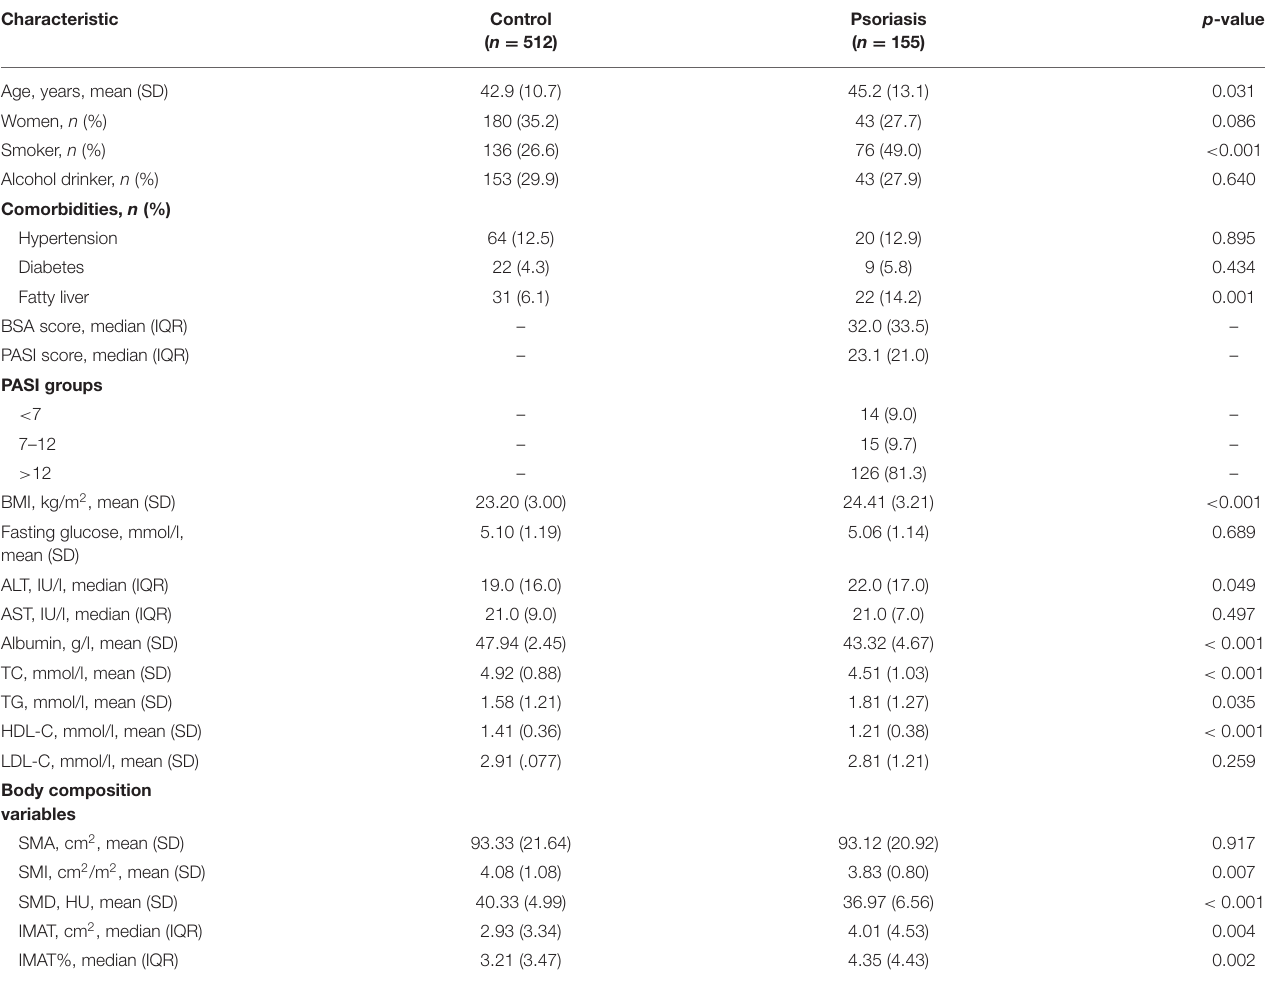
TABLE 1 | Characteristics of the study population.